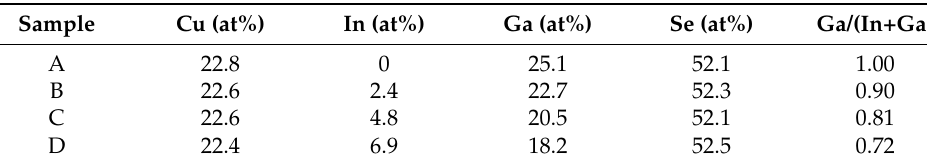
Table 1. Elemental compositions of the CIGS films.